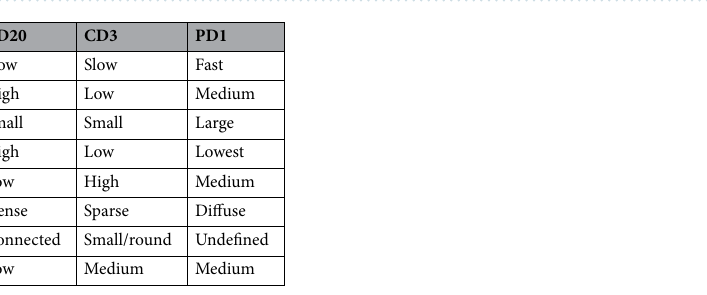
Figure 5. Functional information hidden in the context of cell movement. The rows A and B show the full evaluation of two videos, including traditional 2D morphology and the new movement characteristics. ( A.1 ) shows a dense region near follicular dendritic cells filled with B cells and PD1 positive cells. ( B.1 ) represents a sparse region mainly filled with T cells. The morphologies of the present cells are round and compact. Inspecting tracks and DD clusters of B and T cells inside both regions ( A.2 and B.2 ), we can see an over representation of long and directed tracks inside ( B.2 ). compared to ( A.2 ). The over representation of directed DD clusters indicate a more active region. These hints can be confirmed by the collective behaviour of B cells, T cells and PD1 positive cells. We visualized the optical flow of the last 30 frames of Video A ( A.3 ) and B ( B.3 ). A.3 reveals a localized circular movement pattern indicating patrolling cells inside an interfollicular region, schematically show in figure ( A.4 ). ( B.3 ) reveals an in and outflux of T cells and B cells from a lymphoid follicle, schematically shown in figure ( B.4 ). Here, we can show, that DD clusters and collective movement patterns has the possibility to reveal cellular states and functions, which can not be detected by the evaluation of cell morphologies inside static images.